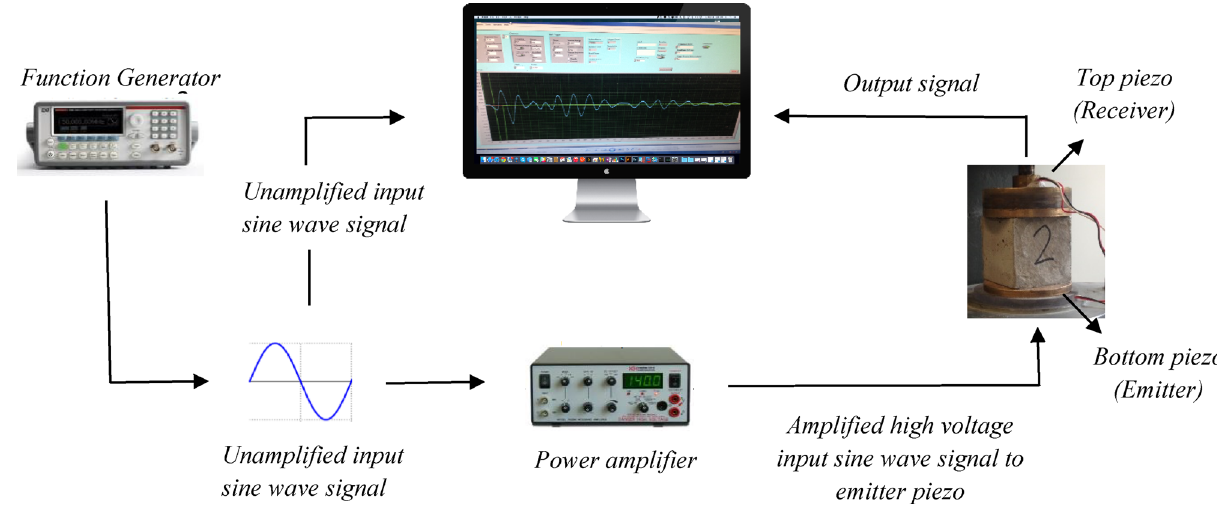
Figure 3. Schematic representation of PRA test set-up.